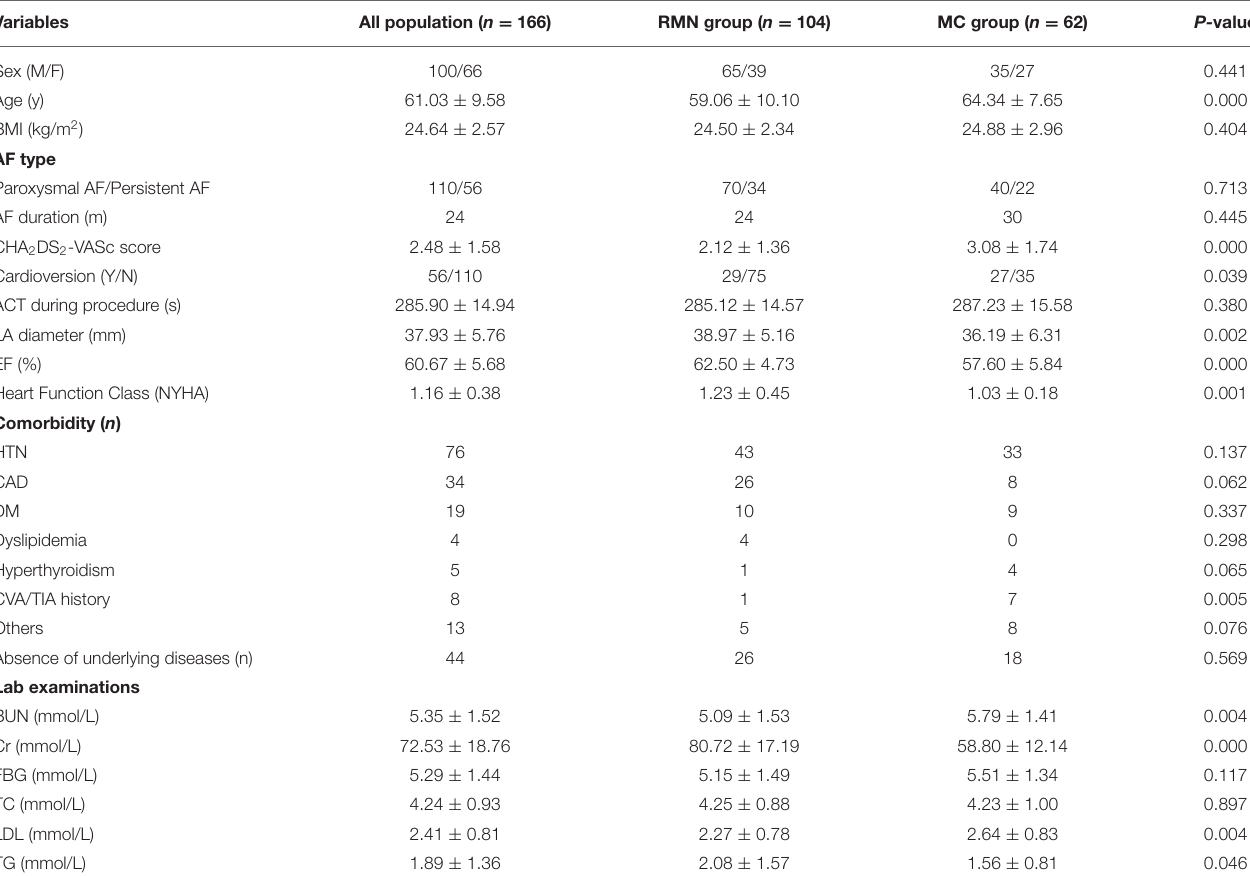
TABLE 1 | Baseline clinical and demographic characteristics of the study population.